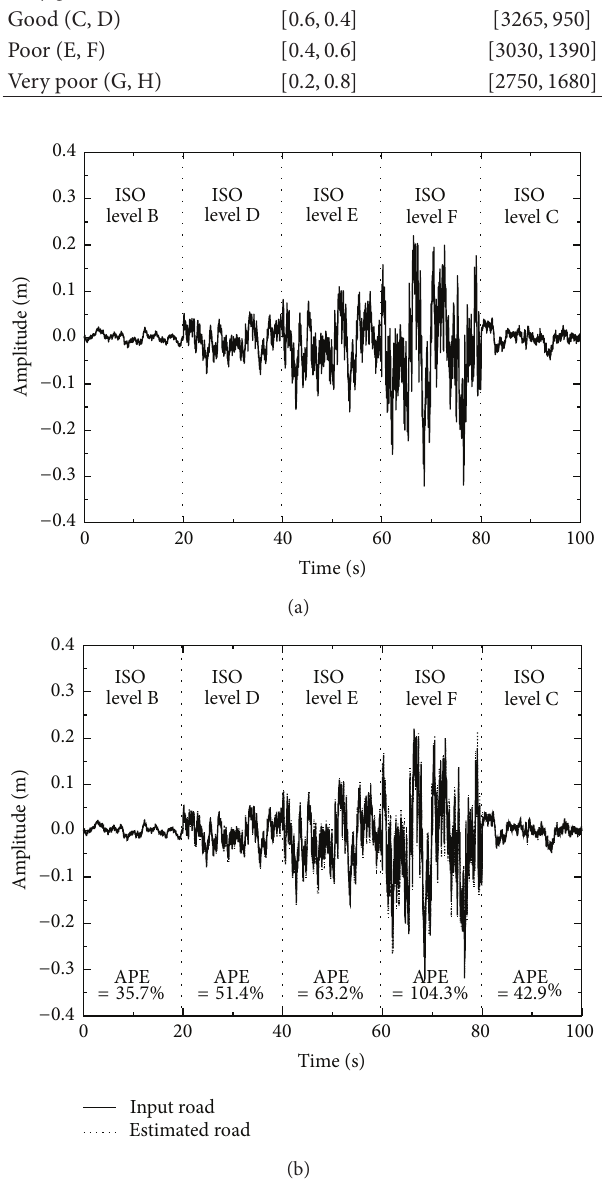
Figure 6: Input road profile and its estimation. (a) Road excitation in time domain, (b) comparison for actual input and estimated road